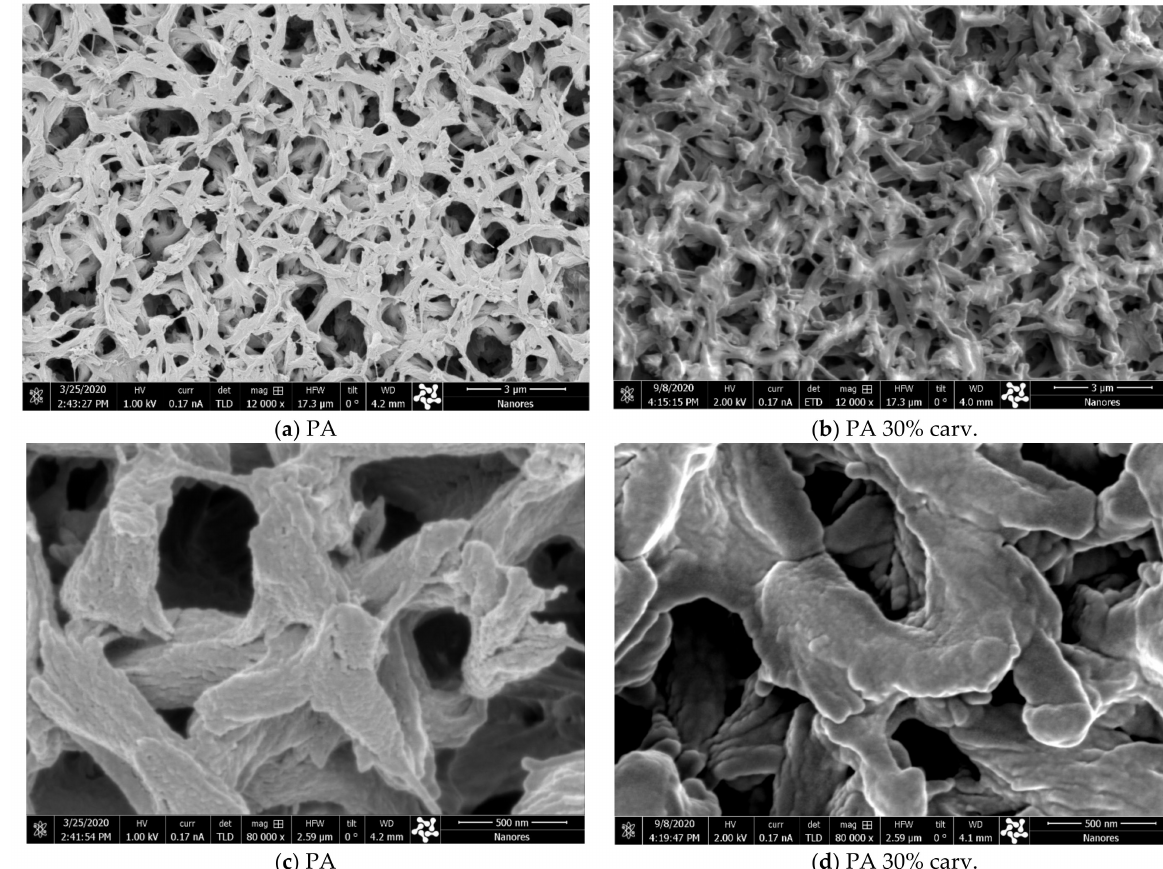
Figure 8. SEM images of surfaces of a neat polyamide membrane (PA) and polyamide membrane with 30 wt.% carvacrol (PA 30% carv.). Bar = 3 µ m in micrographs ( a , b ); bar = 500 nm in micrographs ( c , d